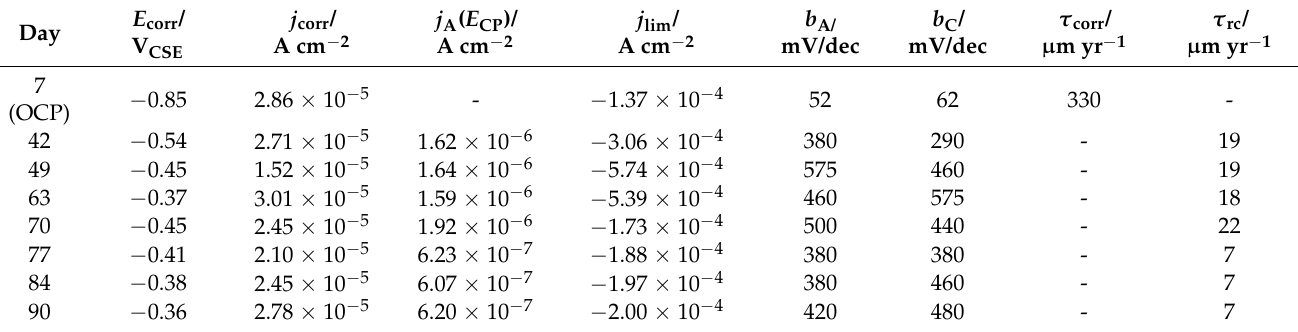
Table 4. Summary of fitted parameters computed from mathematical modelling for coupon WE CP1 (CSE = copper/copper sulfate